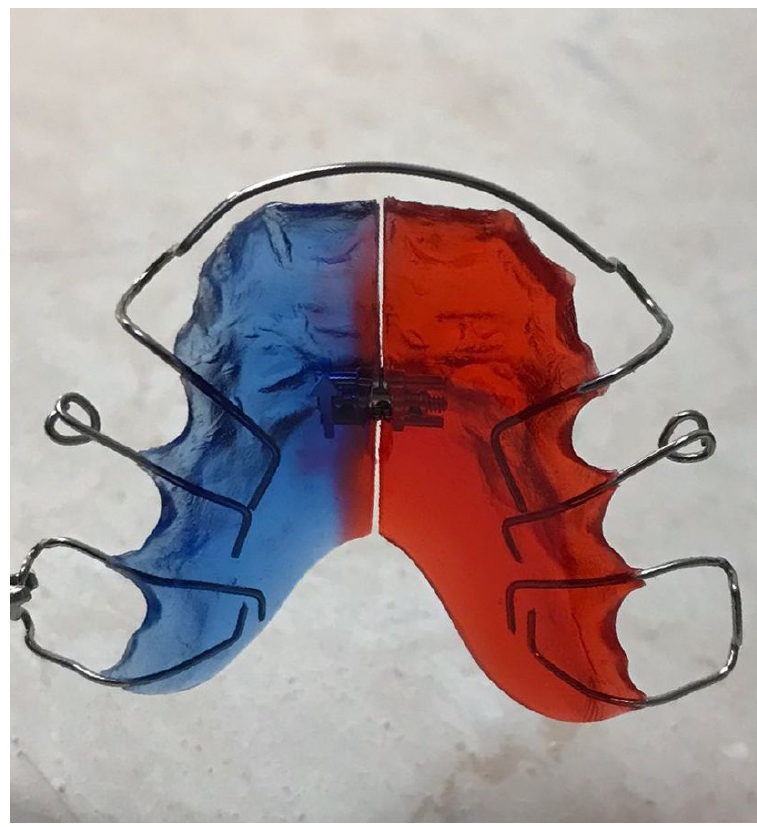
Figure 3. Picture of the acrylic removable appliance (ARA) made by Docs Lab from